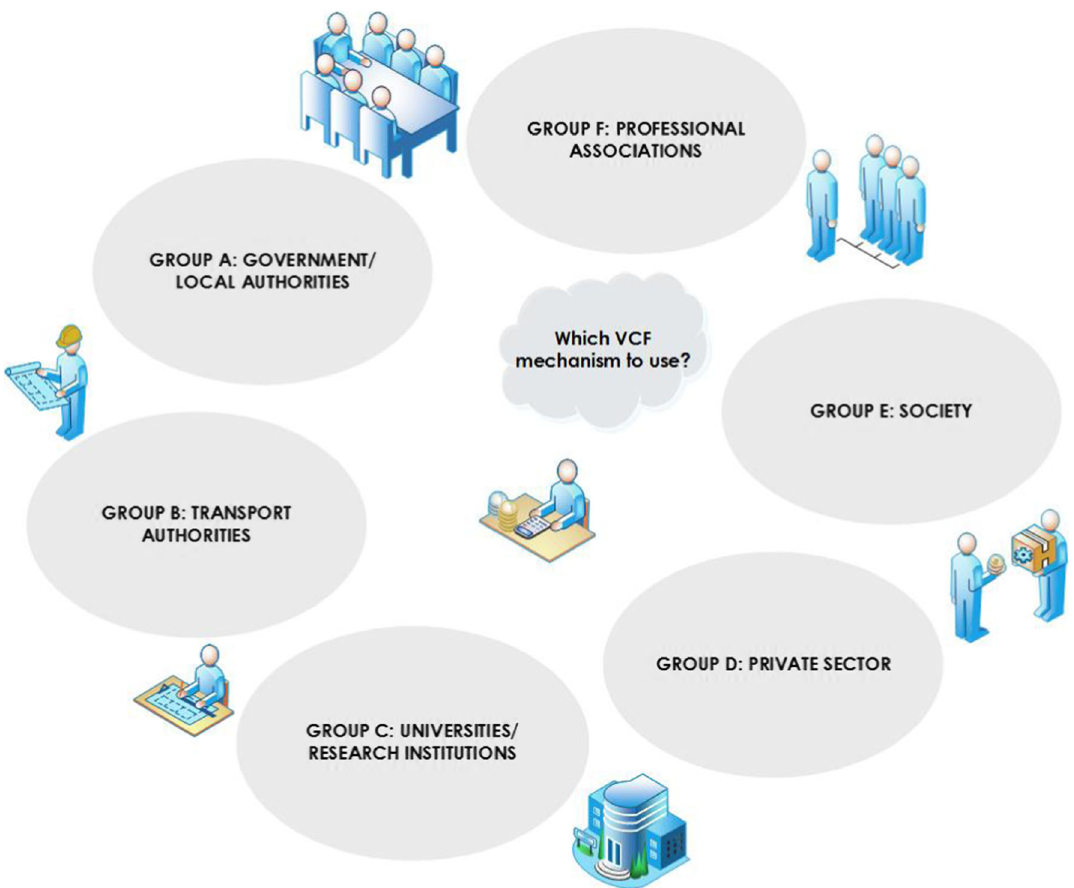
Fig. 2 Stakeholders involved in decision making concerning VCF mechanisms implementation for transportation infrastructure (Own